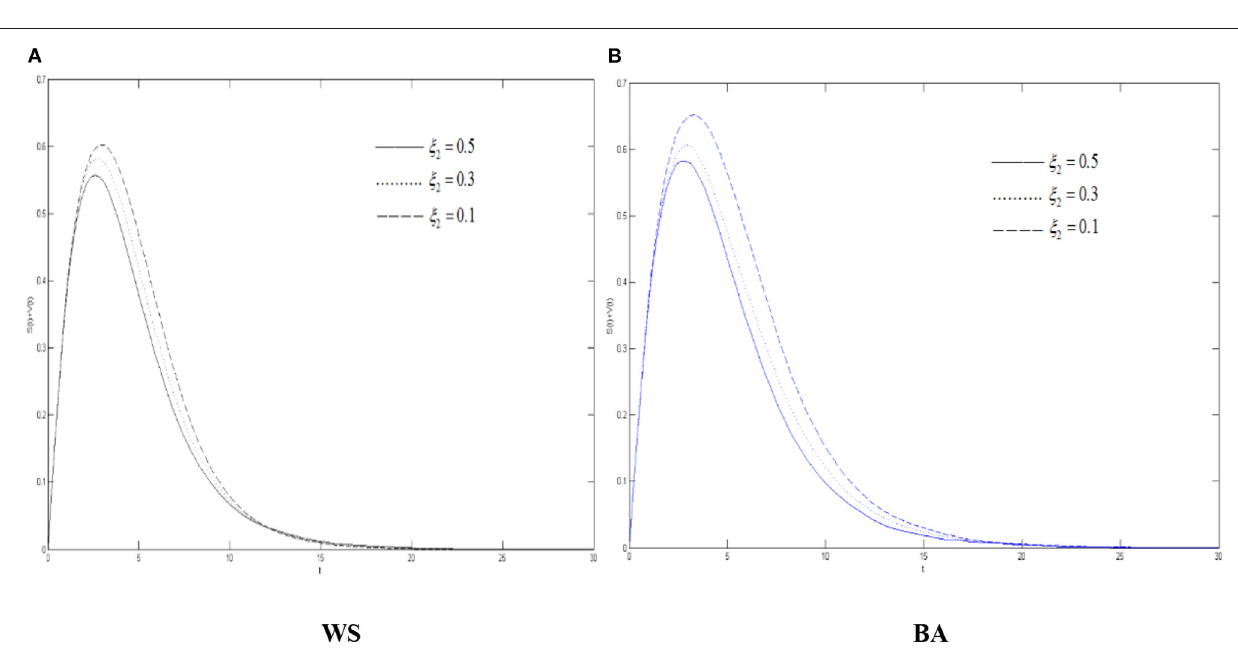
FIGURE 7 | The differences of the oyster density in WS small world and BA scale-free network when µ 2 changes. (A) WS, (B) BA.